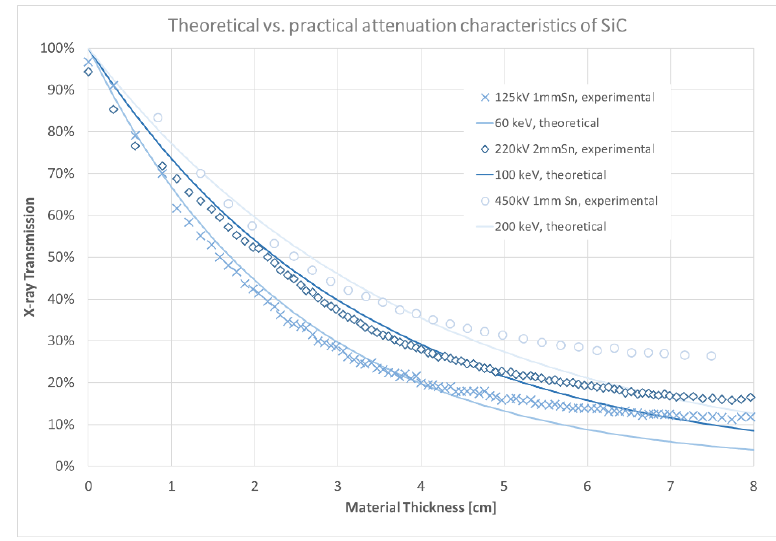
Figure 5. Comparison of the theoretical and experimental attenuation characteristics of SiC at different X-ray energies.